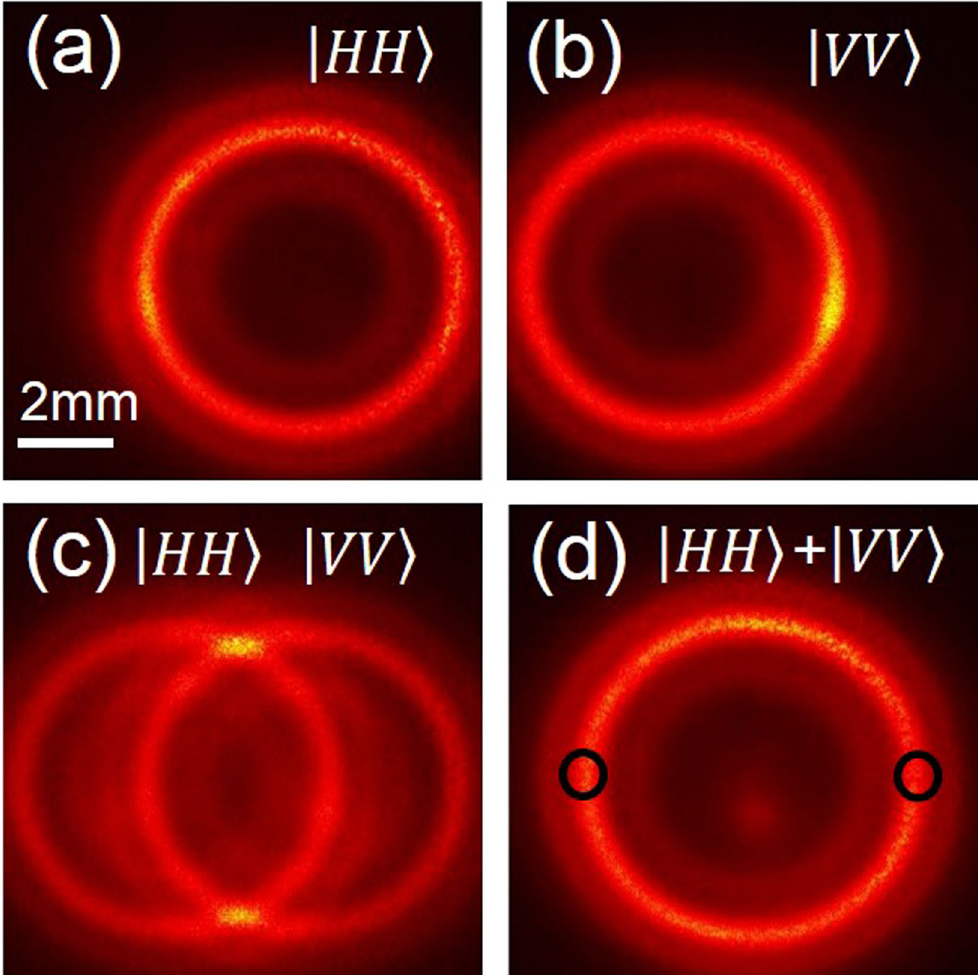
Figure 3. Spatial distribution of the SPDC paired photon recorded using EMCCD. Images of the paired photons of polarization state, ( a ) HH . ( b ) VV ( c ) both HH and VV with misalignment, and ( d ) perfectly overlapped states, HH and VV The black circles represent the diametrically opposite regions on the SPDC ring used for entanglement studies. The pump power used for this measurement is 5